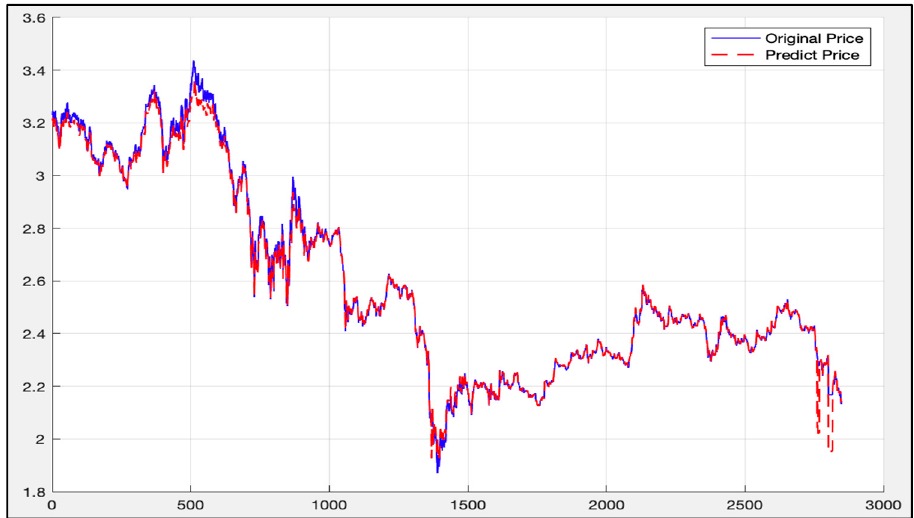
Figure 23. Comparison of LSTM-SVR I prediction results with actual results (first 2850 data).